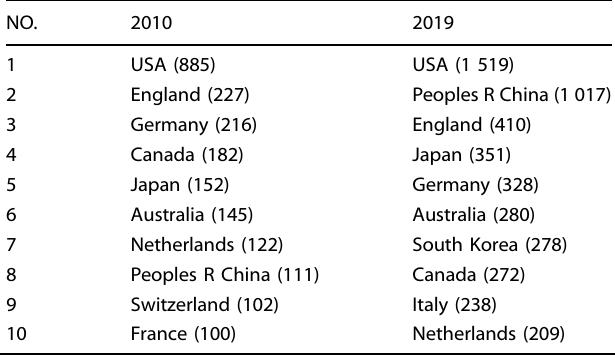
Fig. 4 The publication situation of China and other countries in the fi eld of OA (2010-2019). a The number of publications from China, the USA, the UK and Japan and the proportion funded by the NSFC, the NIH, UKRI and KAKENHI. b Comparison of the numbers of high-level publications among the top four countries. c The data of highly cited papers from different countries in the Web of Science Table 1. Top 10 nations for OA-related publications in 2010 and